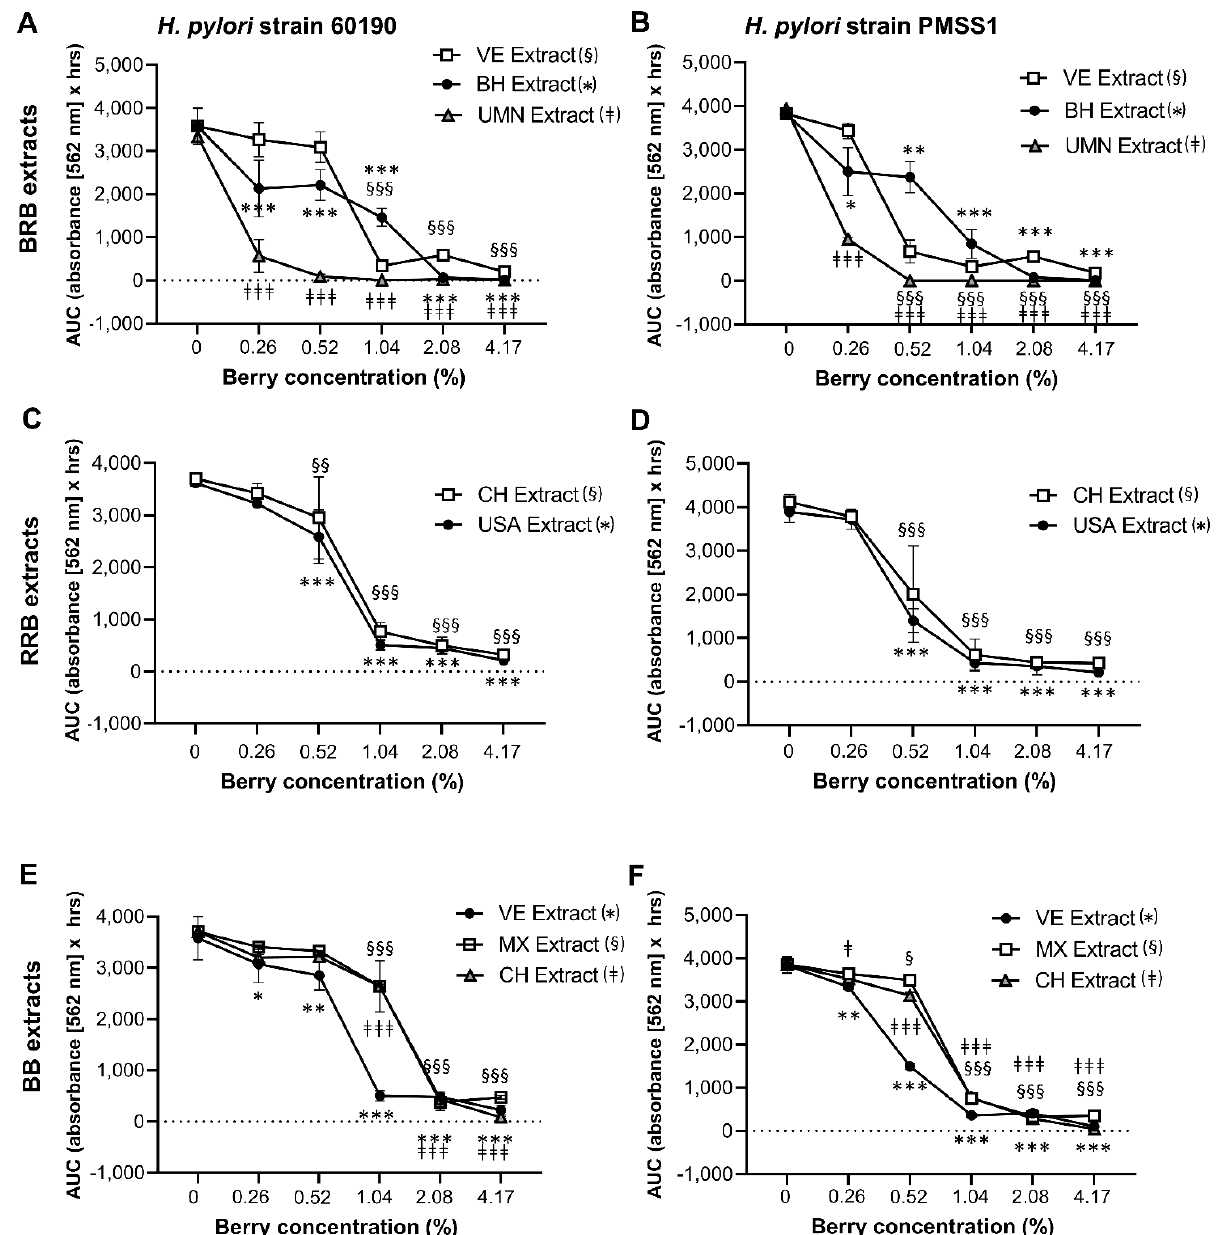
Figure 4. Growth inhibition of H. pylori by extracts from BRB, RRB and BB. Growth of H. pylori in the presence of different concentrations of the BRB, RRB and BB extracts described in Tables 1 and 2. Area under the curve (AUC) for metabolic culture activity was measured over 30 h for strain 60190 with ( A ) BRB extracts, ( C ) RRB extracts and ( E ) BB extracts and for strain PMSS1 with ( B ) BRB extracts, ( D ) RRB extracts and ( F ) BB extracts using the OmniLog ® assay. Pooled data from n = 2–4 independent experiment with 3 technical replicates are shown. Data were analyzed by 2-factorial ANOVA. Tukey’s multiple comparisons test was used to identify differences between a specific concentration of a berry extract and the matching untreated control. Significant differences at p ≤ 0.05/ p ≤ 0.01/ p ≤ 0.001, respectively, are indicated by */**/***, §/§§/§§§ and ‡ / ‡‡ / ‡‡‡ as defined in the panel labels on the right.